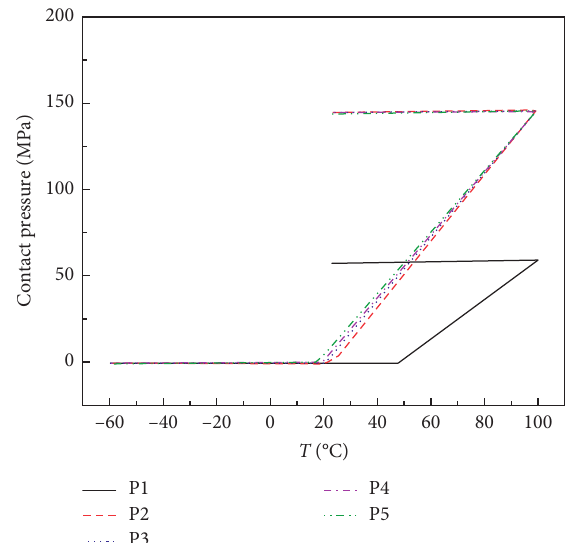
Figure 15: Variations of σ NiTiNb joints against T during heating and cooling for P1 through